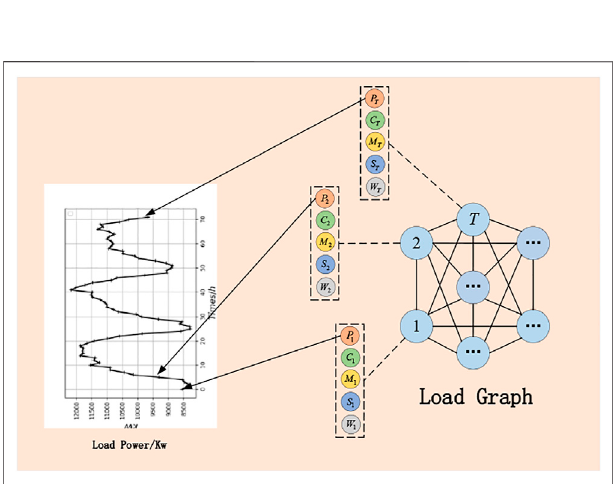
FIGURE 3 | Graph representation of power load and epidemic